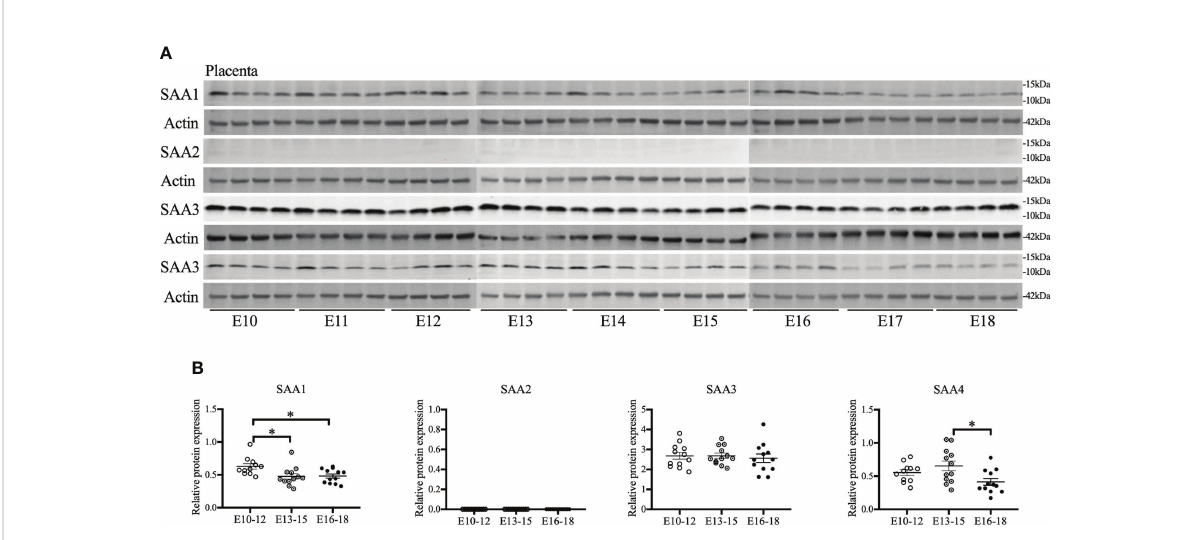
FIGURE 1 The gestational course of serum amyloid A (SAA) isoforms in the placenta. One placenta was harvested daily from each CD-1 dam starting from embryonic (E) day 10 and ending on E18. Western blot was performed to detect the expression of SAA isoforms. (A) Gel images of SAA1 – 4 expression. (B) Statistical analysis of SAA1 – 4 expression normalized to the levels of actin as a loading control. n = 4 dams for each day. Values are expressed as mean ± SEM, * p < 0.05 by one-way